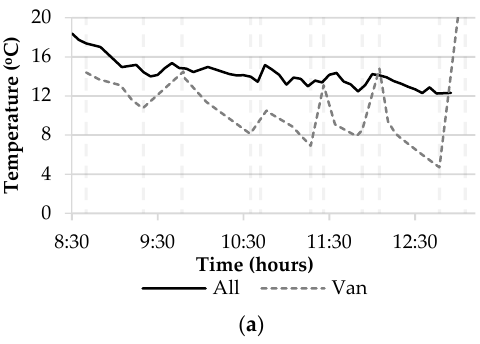
Figure 10. Average measured temperature, and refrigeration system displayed temperature ( a ) and average measured relative humidity ( b ).